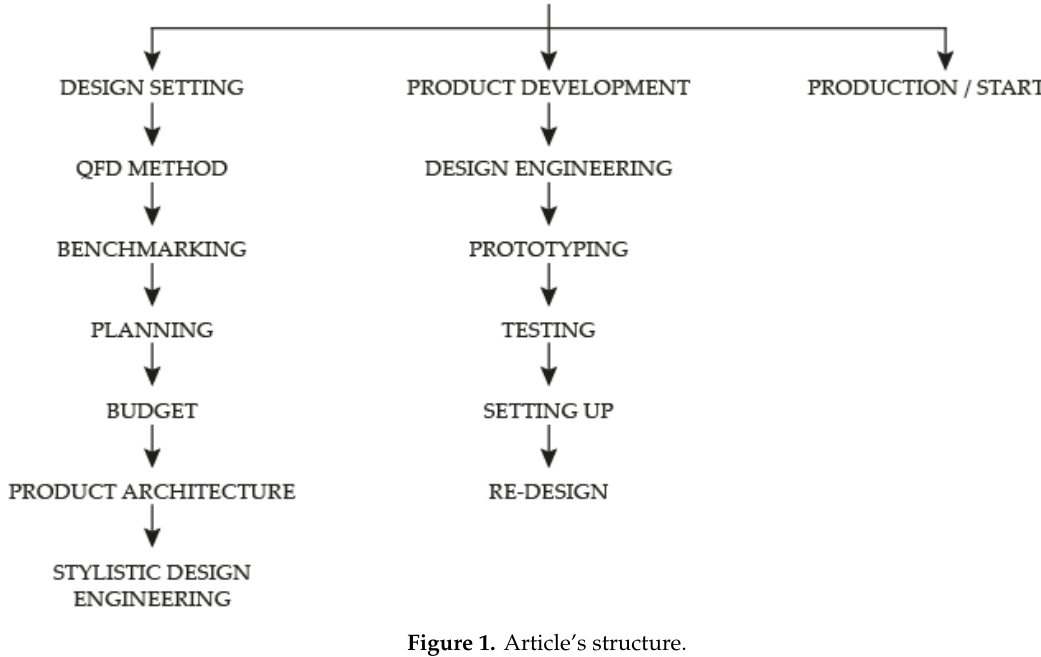
Figure 1. Article’s structure .